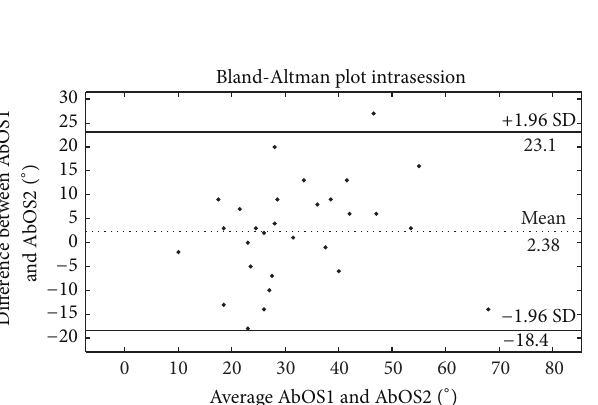
Figure 4: Bland-Altman plots showing the intrasession test–retest reliability of the angle between PO and SP (AbOS). The difference between two consecutive AbOSs is plotted against the mean of the same AbOSs. The central dotted line shows the mean of the differences. The two lines above and below the mean represent the 95% upper and lower limits (two standard deviations).